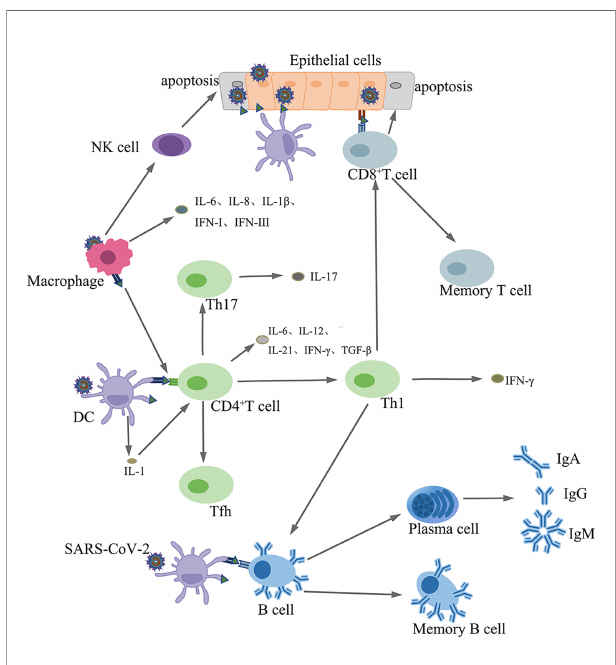
FIGURE 4 | The innate and adaptive immune